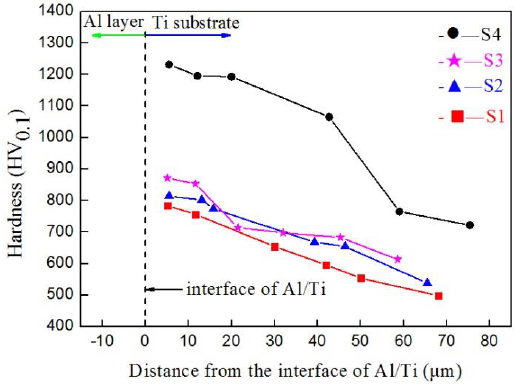
Figure 9. Hardness distribution on the cross-section of samples S1 – S4.